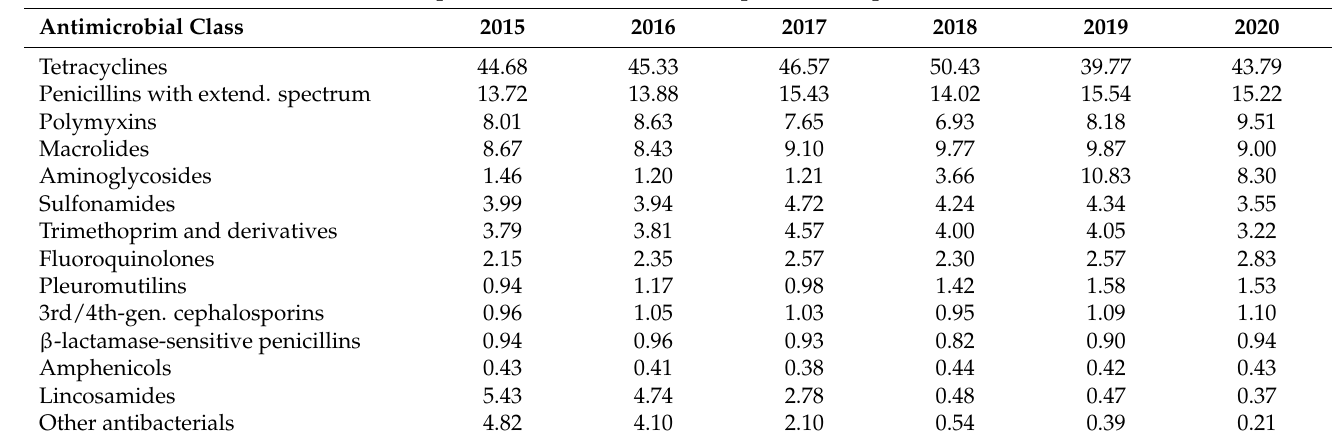
Table 2. Proportion in percent per year of antimicrobial classes dispensed for use in Austrian pigs, based on the European Medicines Agency’s DDDvet. Proportion of Antimicrobials Dispensed in % per Year